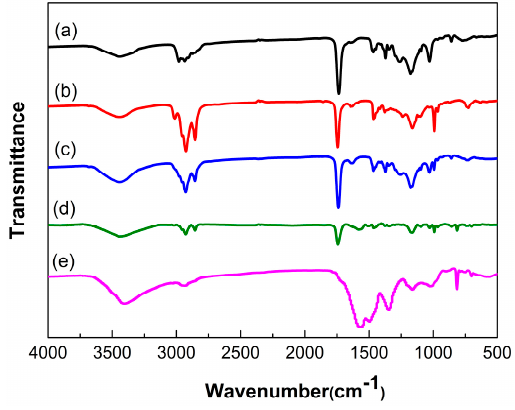
Figure 10. FTIR spectra of ( a ) PAE; ( b ) TO; ( c ) the mixture of PAE and TO; ( d ) microencapsulated PAE-TO and ( e ) MF shell.